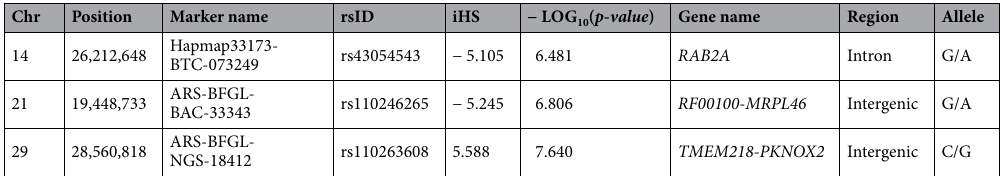
Table 1. List of significant single-nucleotide polymorphisms (SNPs) from the integrated haplotype score (iHS) results. 1 Chr: Chromosome. 2 iHS: Integrated Haplotype Score.